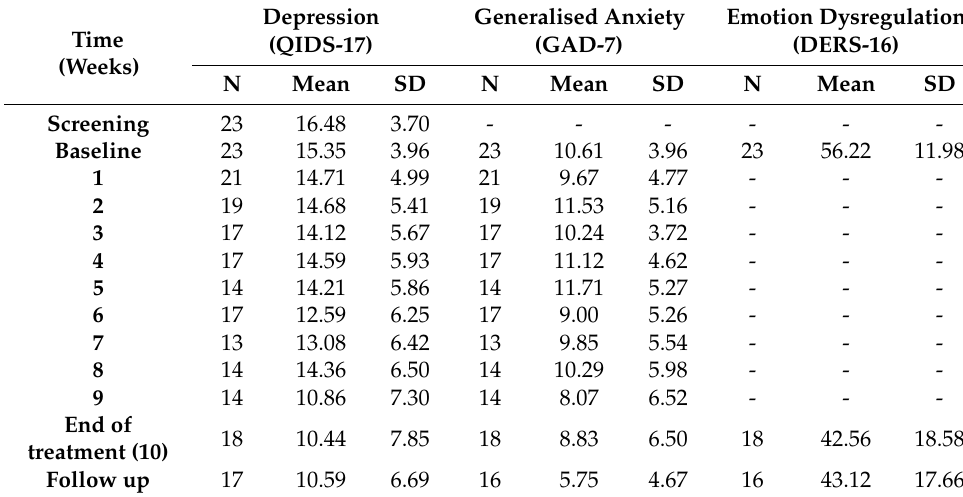
Table 2. Participant Time